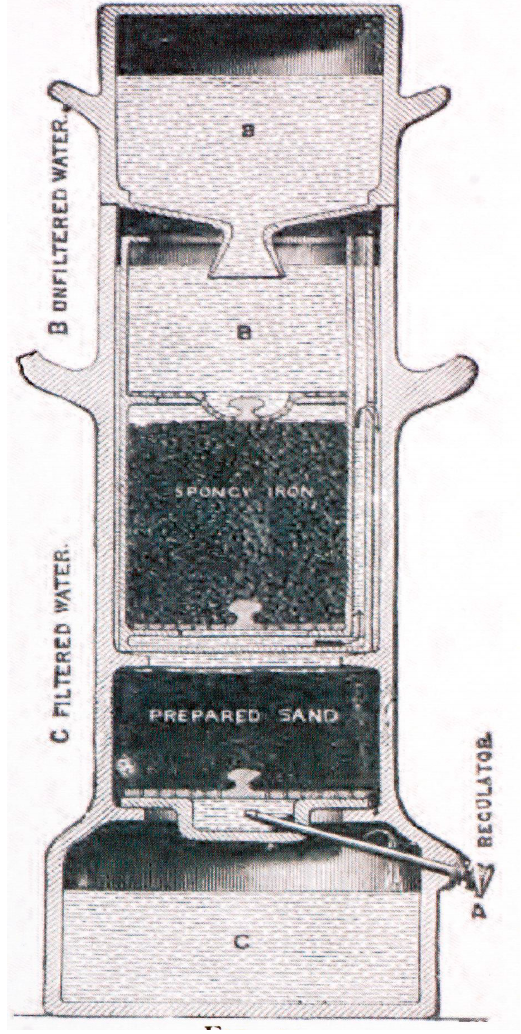
Figure 1. Photograph of a “spongy iron” filter as published by Nichols [48]. The raw water ( B ) is supplied from a bottle, which is inverted into the upper part of the inner vessel. Spongy iron (Fe 0 ) is contained in an inner vessel. Below the Fe 0 material are: (i) A layer of sand (‘prepared sand’), (ii) a regulator ( A ), and (iii) a receptacle ( C ) with a tap for filtered water. Prepared sand consists of three layers of aggregates: Pyrolusite (MnO 2 ), sand, and gravel, which separate traces of iron from the filtrate.